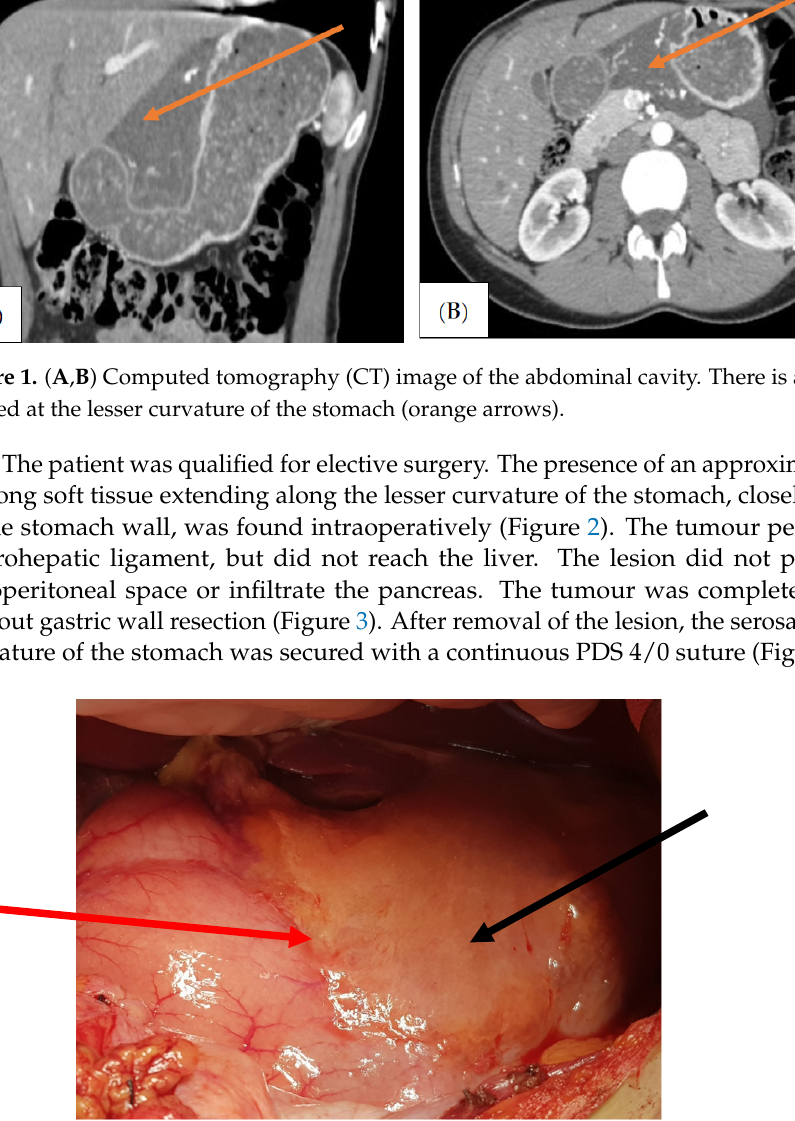
Figure 2. Intraoperative image—The tumour was close to the lesser curvature of the stomach. The arrows indicate: the lesser curvature of the stomach (red arrow), and the anterior surface of the tumour (black arrow) .